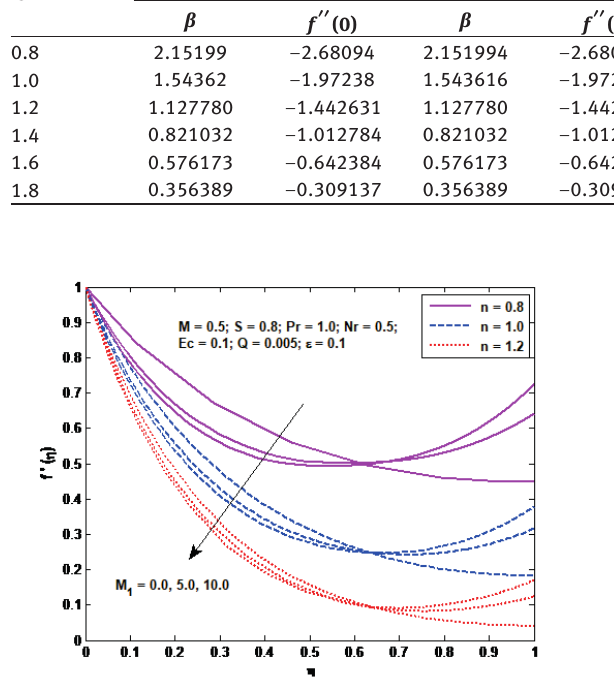
Fig. 3: Horizontal velocity profiles for different values of M 1